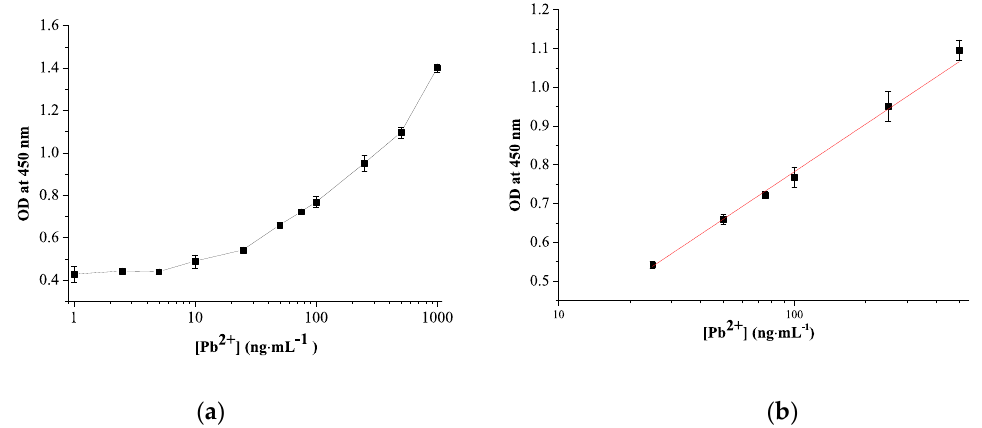
Figure 6. Calibration curve for detection of Pb2+ ions using TA-capped AuNPs ( a ) and its linear range ( b ) ( N = 3). Table 2. Comparison of the developed analysis for Pb 2+ with previously reported colorimetric methods .